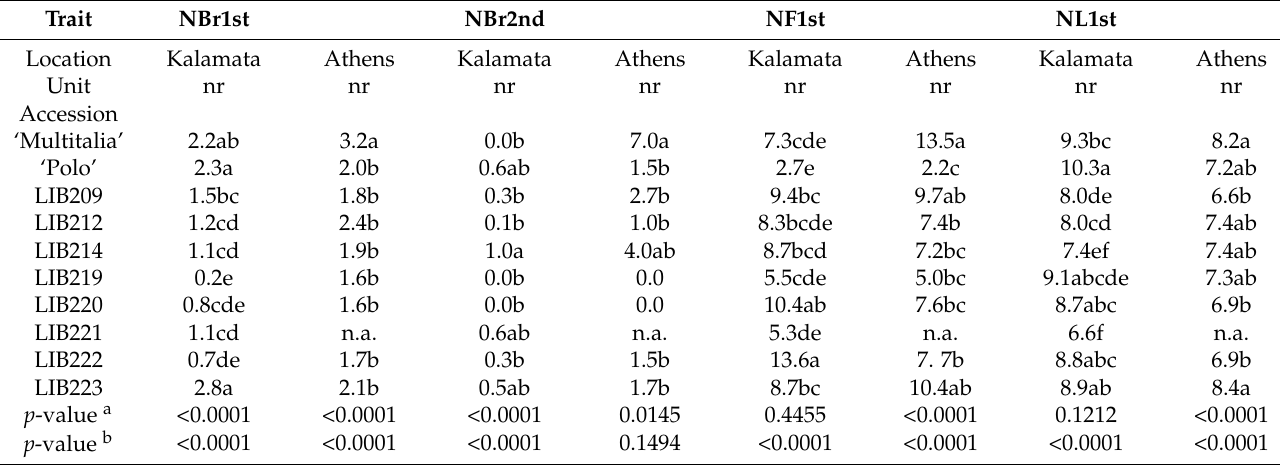
Table 3. Mean number of branches in first, second order and the respective number of flowers and leaves in the first order, among L. mutabilis accessions in comparison to white (‘Multitalia’) and narrow-leafed lupin (‘Polo’) in Kalamata and Athens locations.